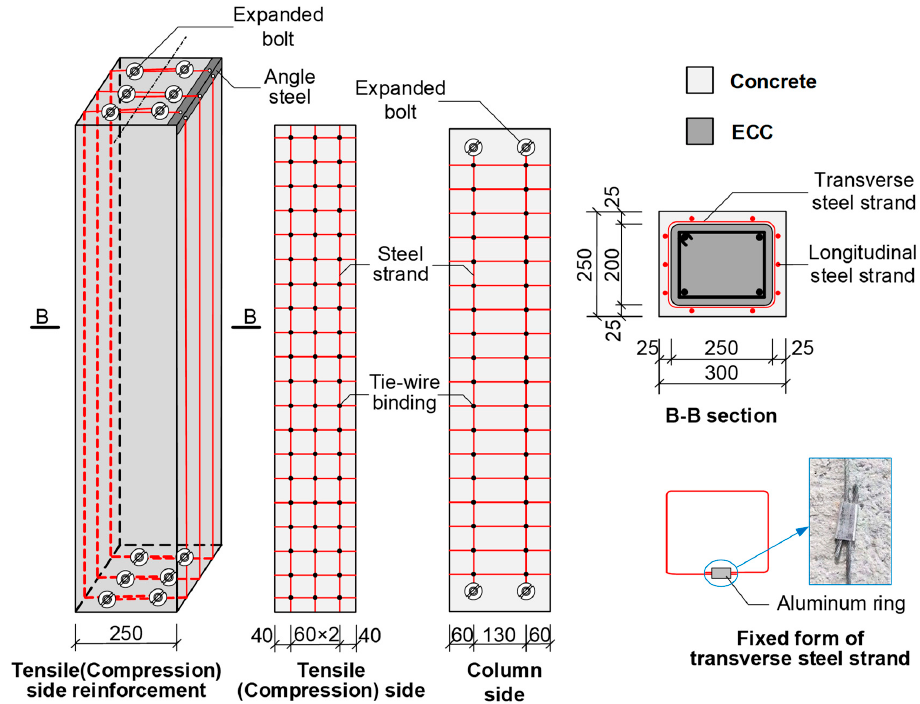
Figure 2. Detail of strengthened column (Dimensions in mm). Table 1. Test parameters of specimens.